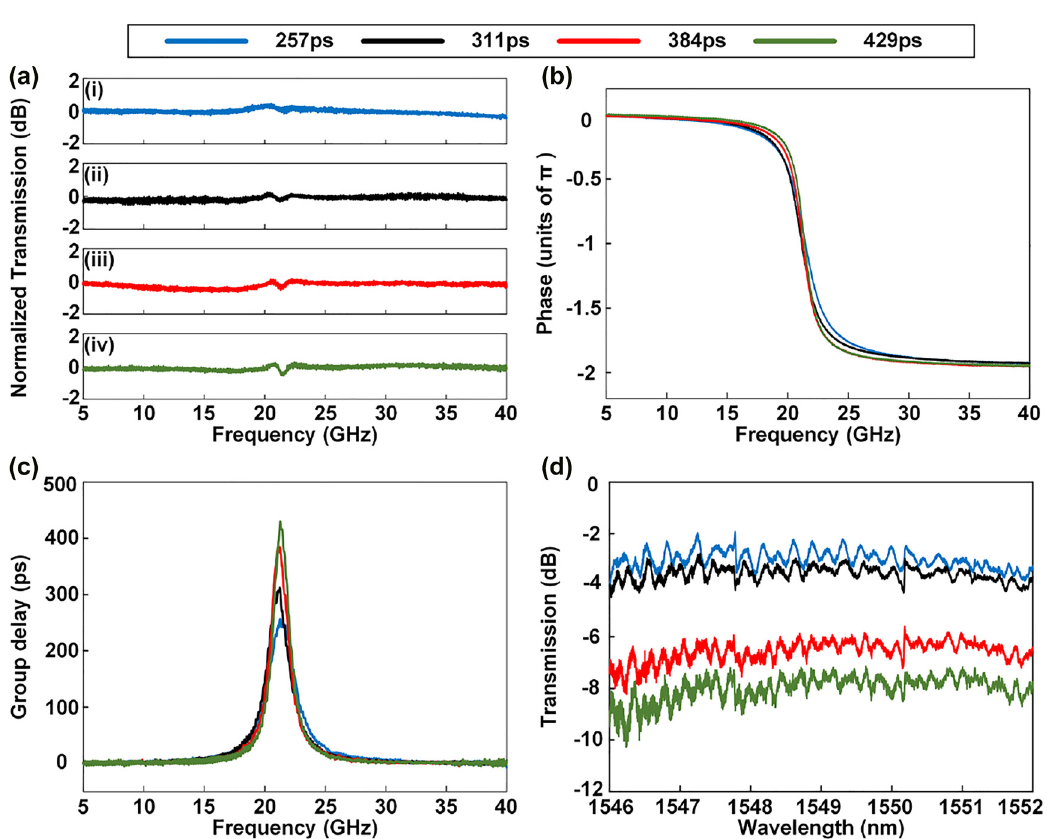
, H , H , and H are 2 4 5 6